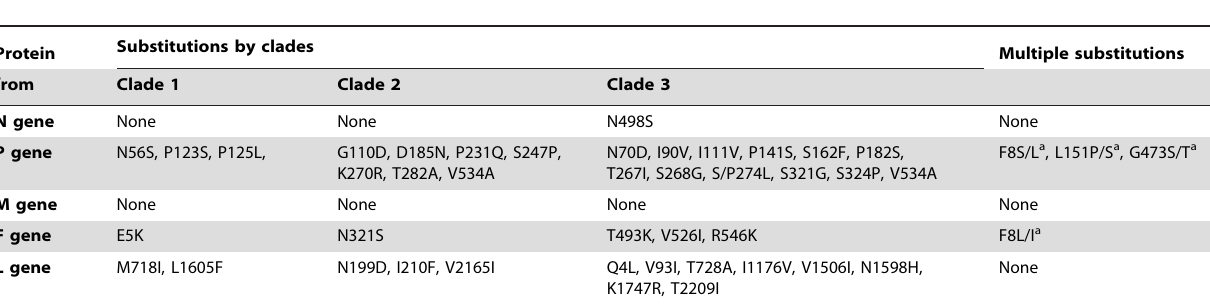
Table 3. Clade-Scale Amino Acid Substitutions from the N, P, M, F and L Proteins of 40 Recently Sequenced HPIV-1 Complete Genomes (the HN protein is described in greater detail in Table 4 and is not included here).